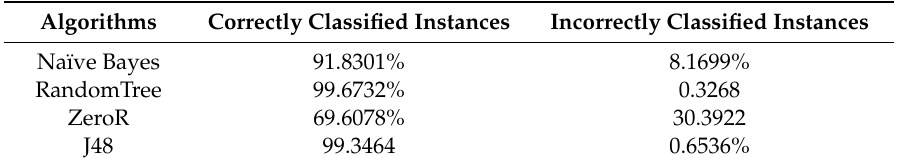
Table 2. The accuracy